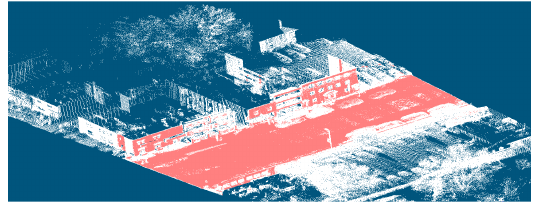
Figure 10. Histogram of the 3D density of the point cloud- Auriga Dr data.